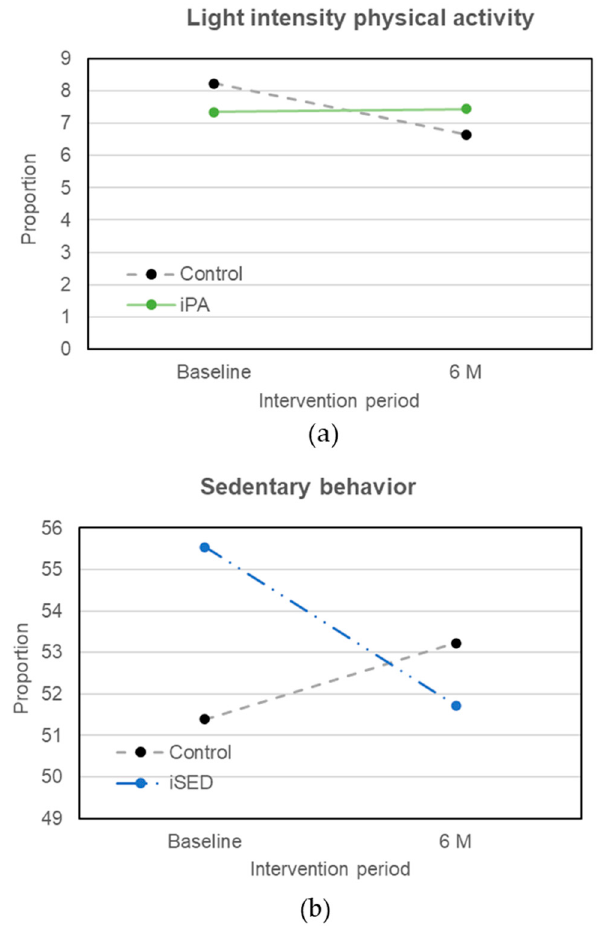
Figure 3. Intervention effect on physical activity patterns among those with a high executive function and active jobs. Notes: ( a ) shows changes in light intensity physical activity between control group and intervention group targeting physical activity; ( b ) shows the changes in sedentary time between control group and intervention group targeting sedentary behavior.